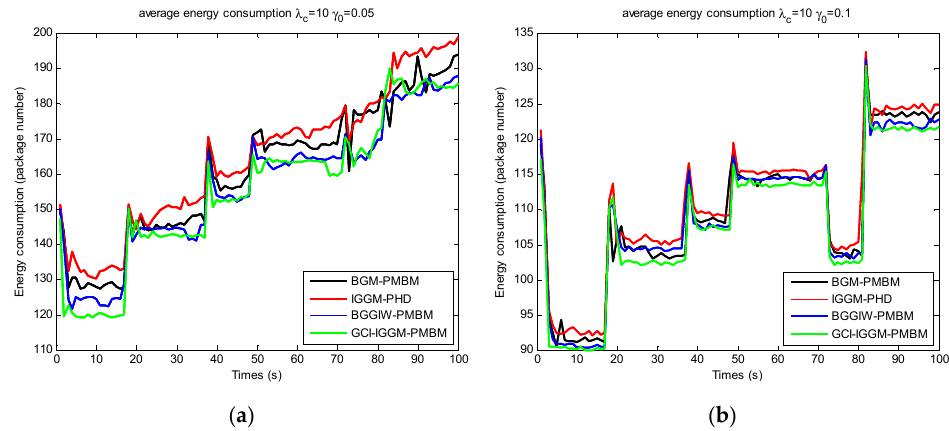
γ of GCI–IGGM–PMBM with 0 γ 0